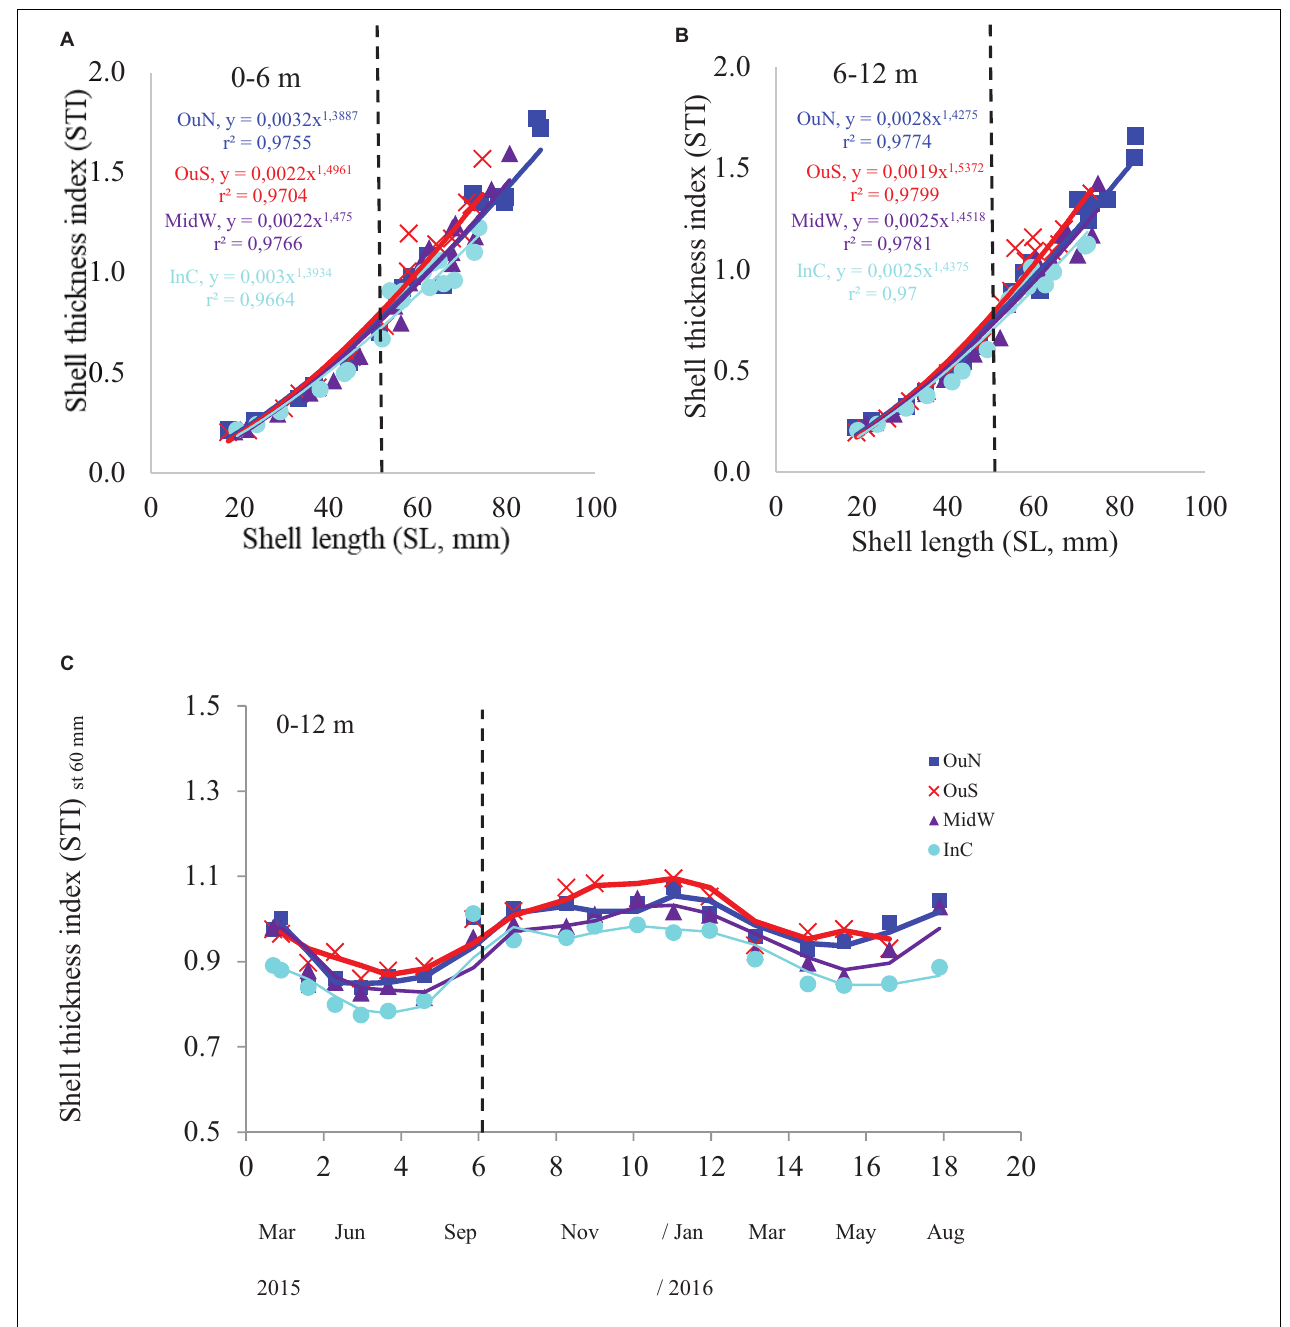
FIGURE 4 | (A) Shell thickness index (STI) of the mussels cultivated at the four different locations in the Ría de Arousa at depths of (A) 0–6 and (B) 6–12 m in relation to mussel size (SL, mm). Variability in STI in relation to (C) cultivation time once standardized to a common mussel size of 60 mm shell length. The dashed line represents the timing of the thinning out process usually carried out between seeding and harvest.